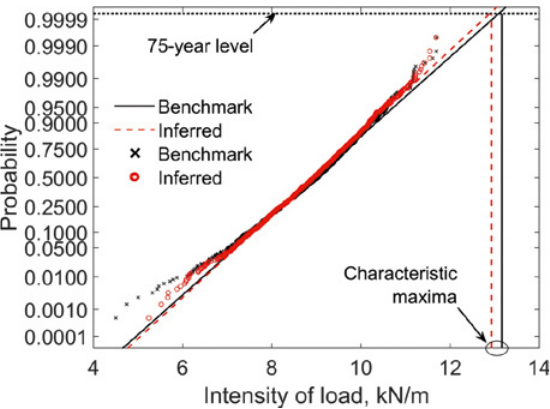
Figure 8. Normal probability paper plot of the benchmark and inferred distributions of load intensity for 500 m bridge